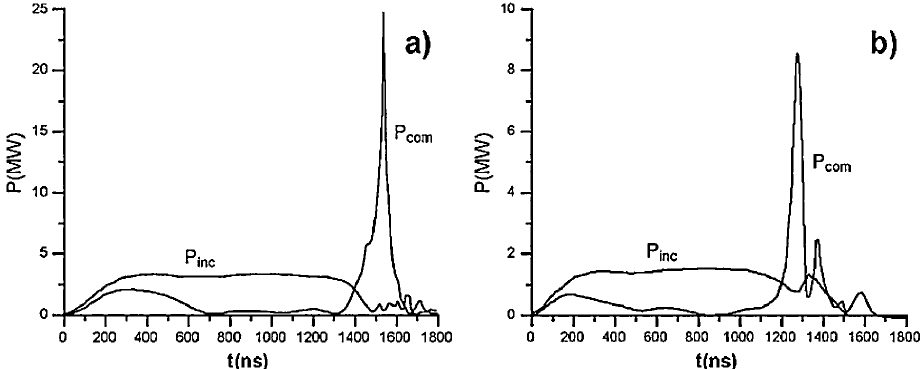
FIG. 14. Oscilloscope traces of the incident and compressed pulse for triggered operation of the two-channel compressor with the switch based on mode conversion. (a) Switch setting corresponding to a peak to the left of curve 1 in Fig. 11, pressure (cid:2) 0 : 02 – 0 : 05 Torr . (b) Switch setting corresponding to curve 1 in Fig. 11, pressure (cid:2) 0 : 2 – 0 : 5 Torr